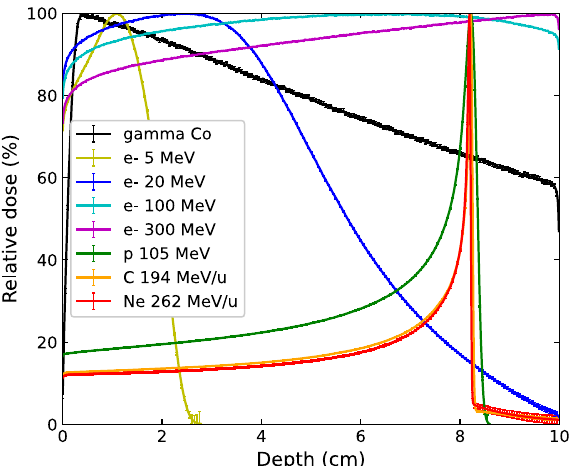
Figure 2. Depth-dose profiles in water obtained for different photon, clinical electrons, VHEE and ion beams of size 2 × 2 cm 2 . Doses lower than 0.1% of max dose are not shown. Uncertainties on absorbed doses in central axis voxels are less than 1%.